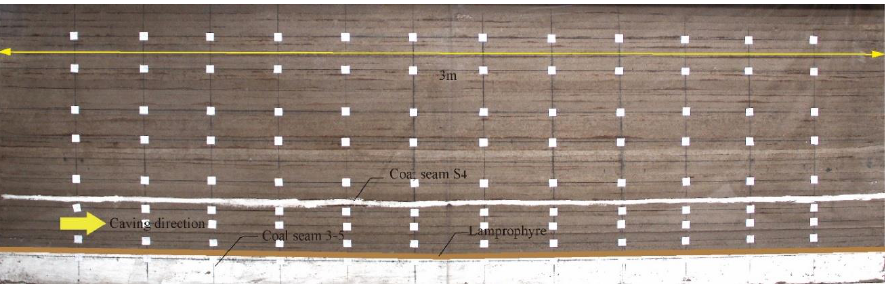
Figure 4. Physical model.